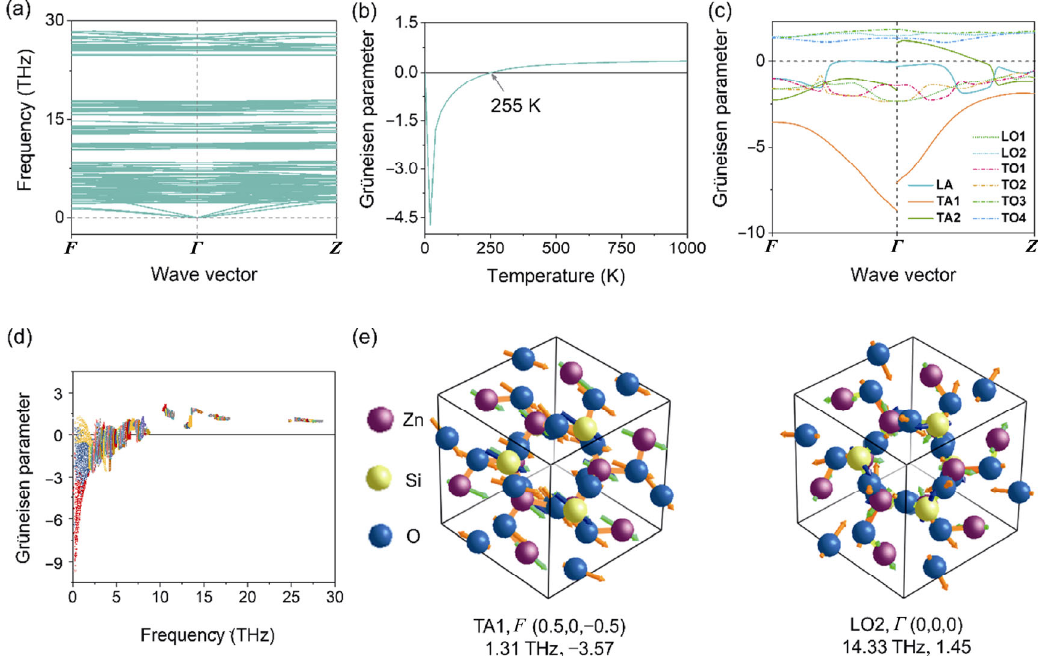
Fig. 9 Dependence of temperature and vibration modes on the Grüneisen parameter of Zn 2 SiO 4 . (a) Phonon dispersion, (b) temperature dependence of Grüneisen parameter, (c) high symmetric point distribution of Grüneisen parameter, (d) calculated mode Grüneisen parameter as a function of frequency (the colors represent different vibration modes), and (e) schematic diagrams of the phonon eigenvectors at the high symmetry points of F and Γ . For each mode, the wave vector, frequency, and Grüneisen parameter are indicated below each illustration in